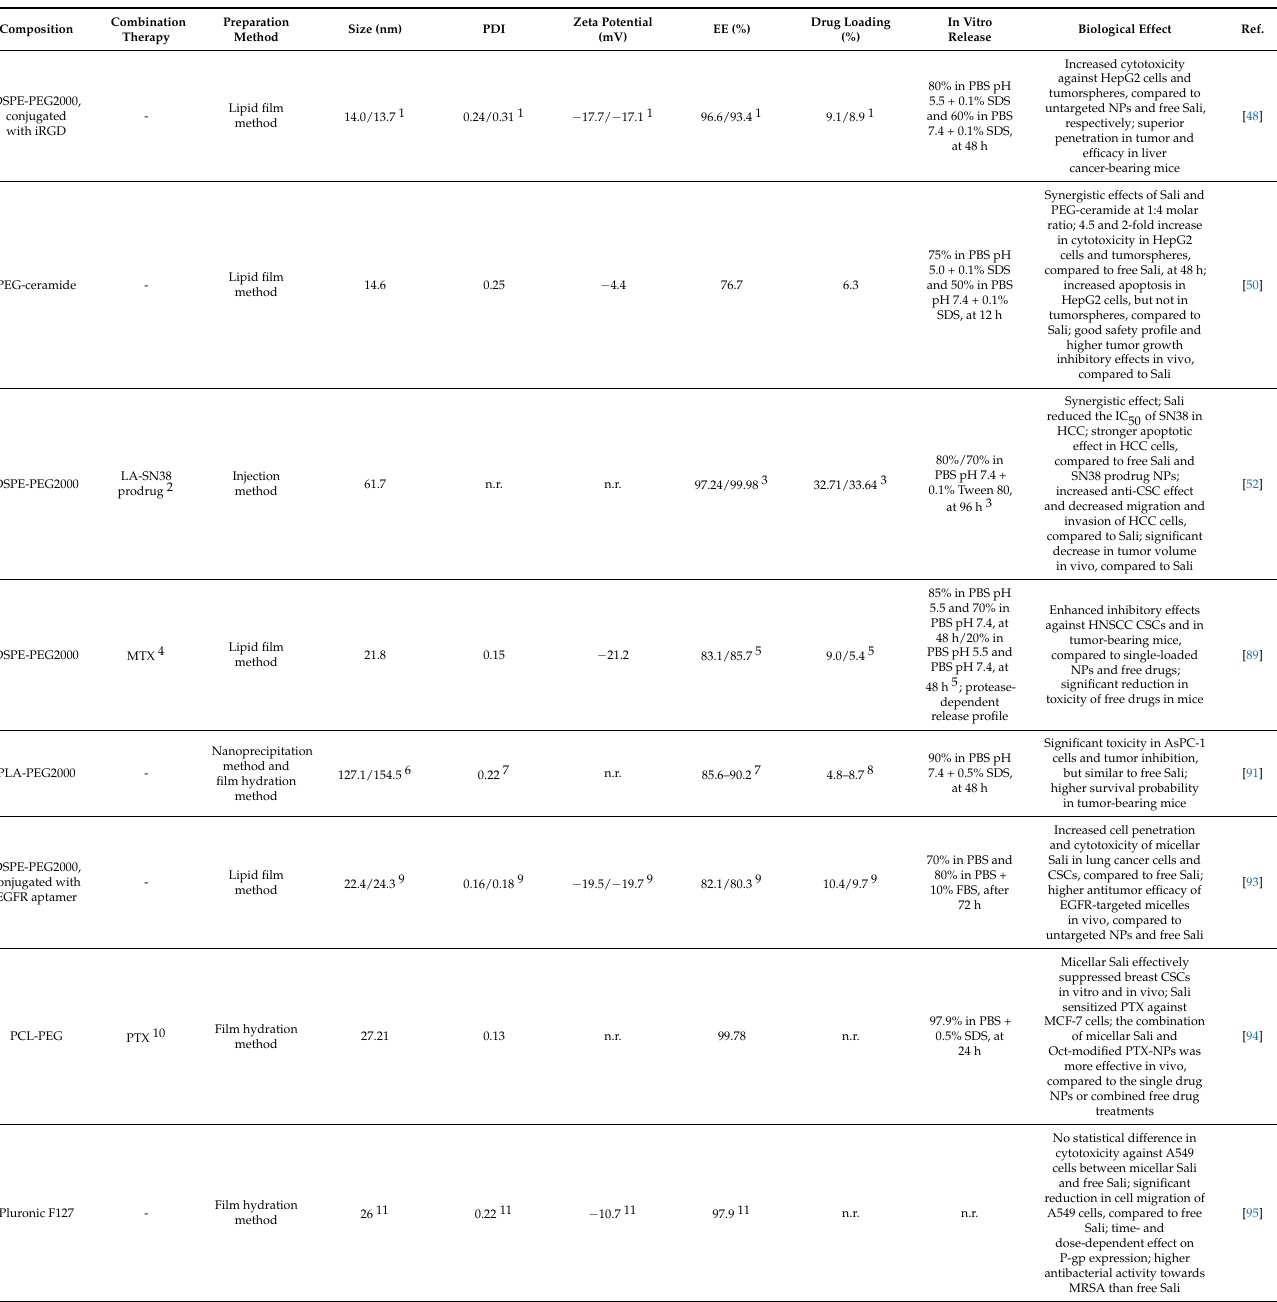
Table 6. Micellar formulations with